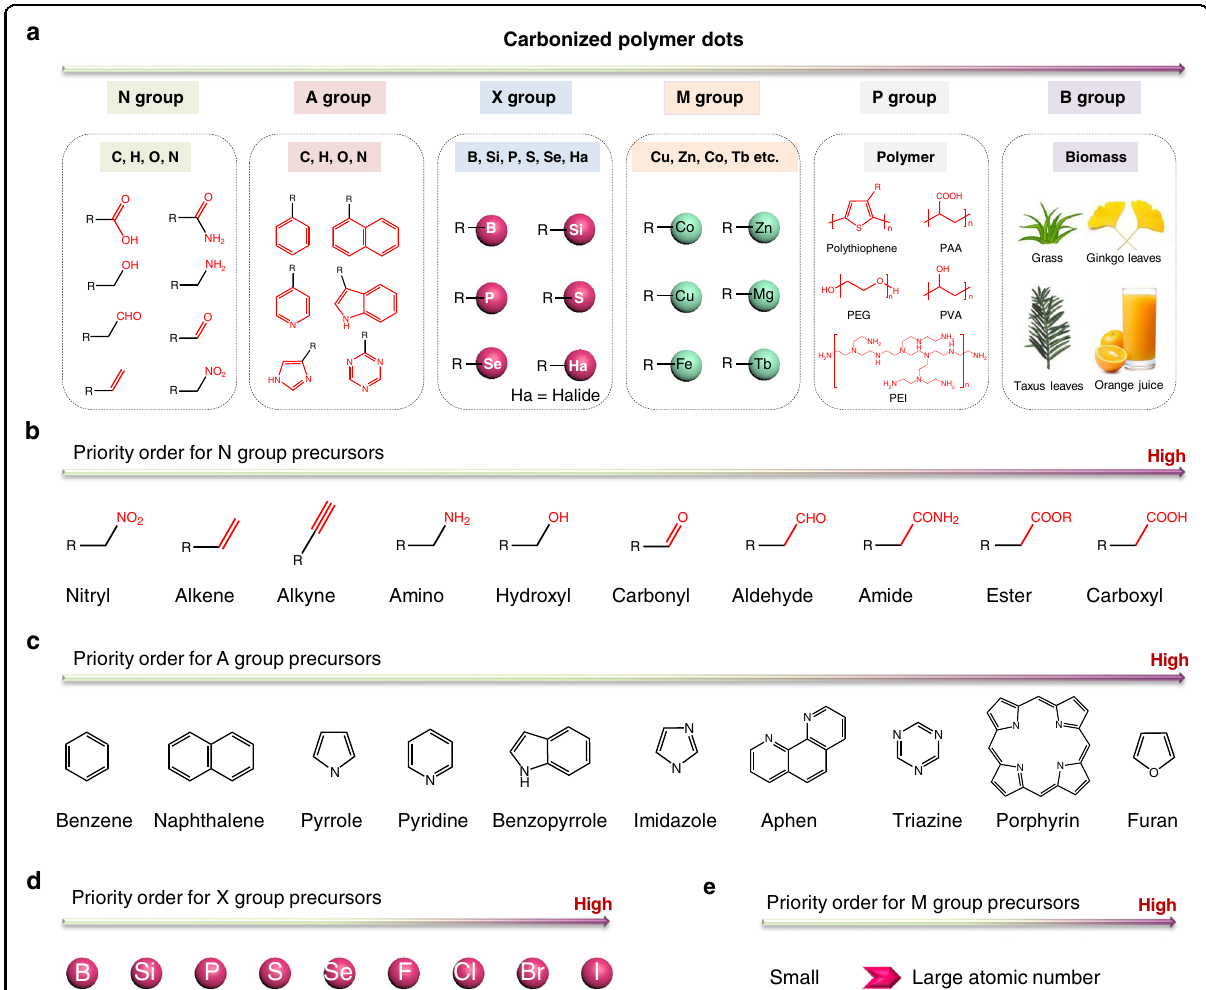
Fig. 4 Classi fi cation and nomenclature of CPDs. a Classi fi cation of CPDs based on the precursor structure and elemental composition. b Priority order of the nonconjugated precursors based on the functional groups. c Priority order of the aromatic precursors based on the conjugated rings. d Priority order of the nonmetal-doped precursors. e Priority order of the metal-containing